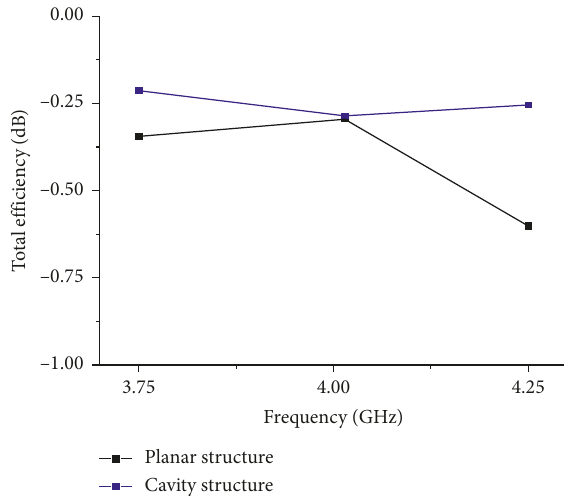
Figure 4: Simulated total efficiency in free-space of the planar and cavity-backed antennas. Table 2: Maximum gain values in free-space of the planar and cavity-backed structures per cut plane.